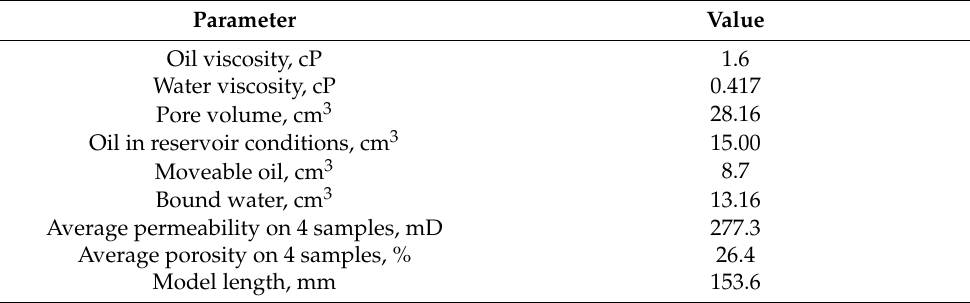
Table 4. Final model parameters.